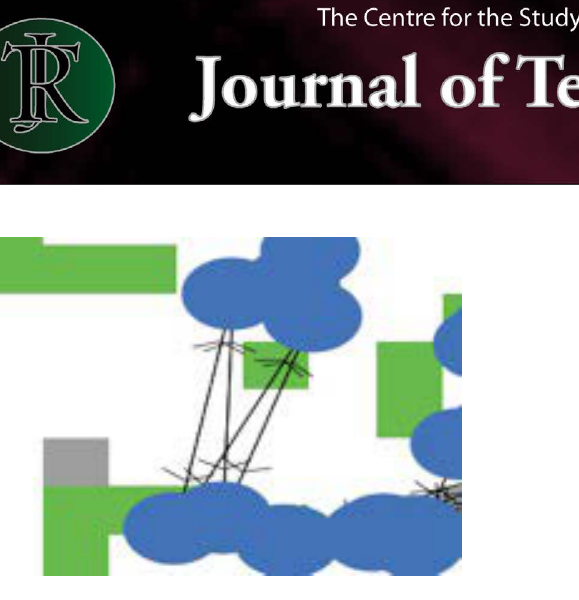
= 39) . The model is paused at 18 Active